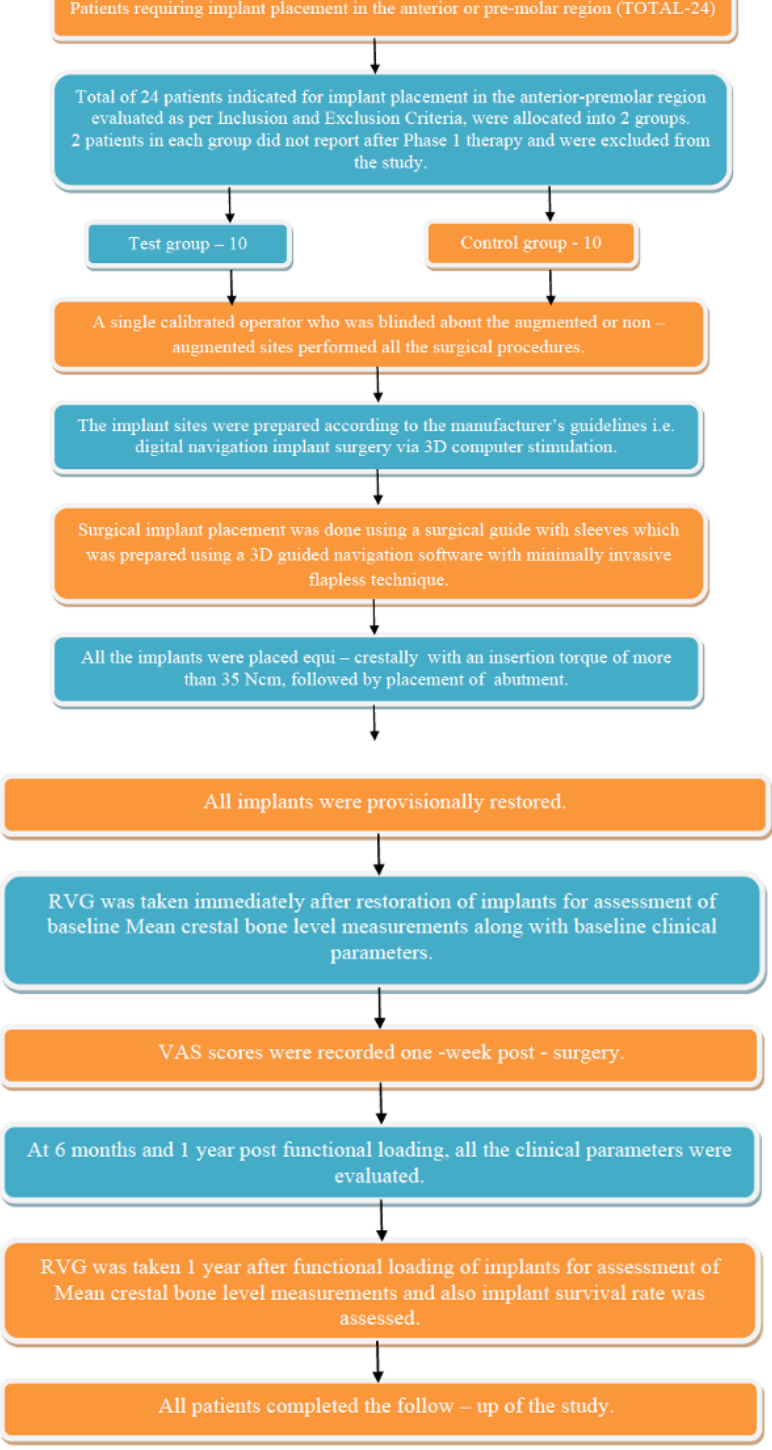
Figure 1. Schematic representation of the study protocol.